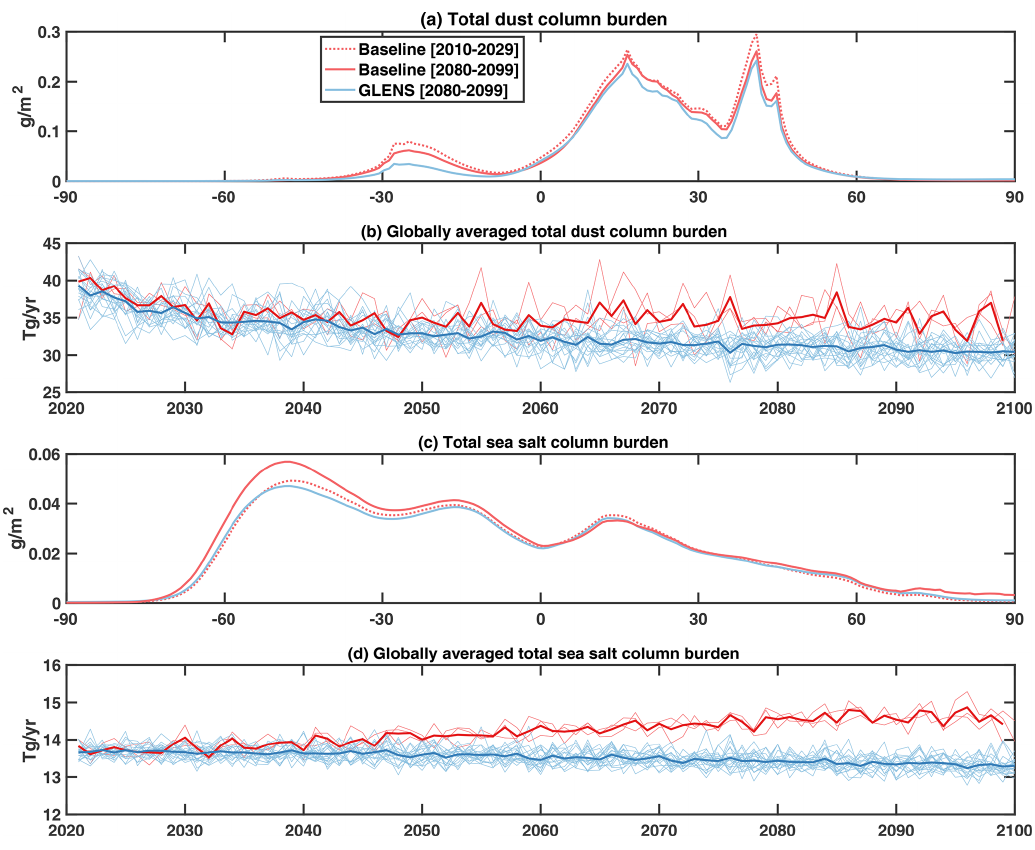
Figure 2. Zonally averaged total column burden of dust (a) and sea salt (c) (considering all modes) in 2010–2029 (red dashed line), 2080– 2099 in Baseline (red line) and 2080–2099 in GLENS (blue line). Evolution of the globally integrated dust (b) and sea salt (d) burden (Tgyr − 1 ). Thinner lines show the single ensemble realizations, while the thicker lines show the ensemble